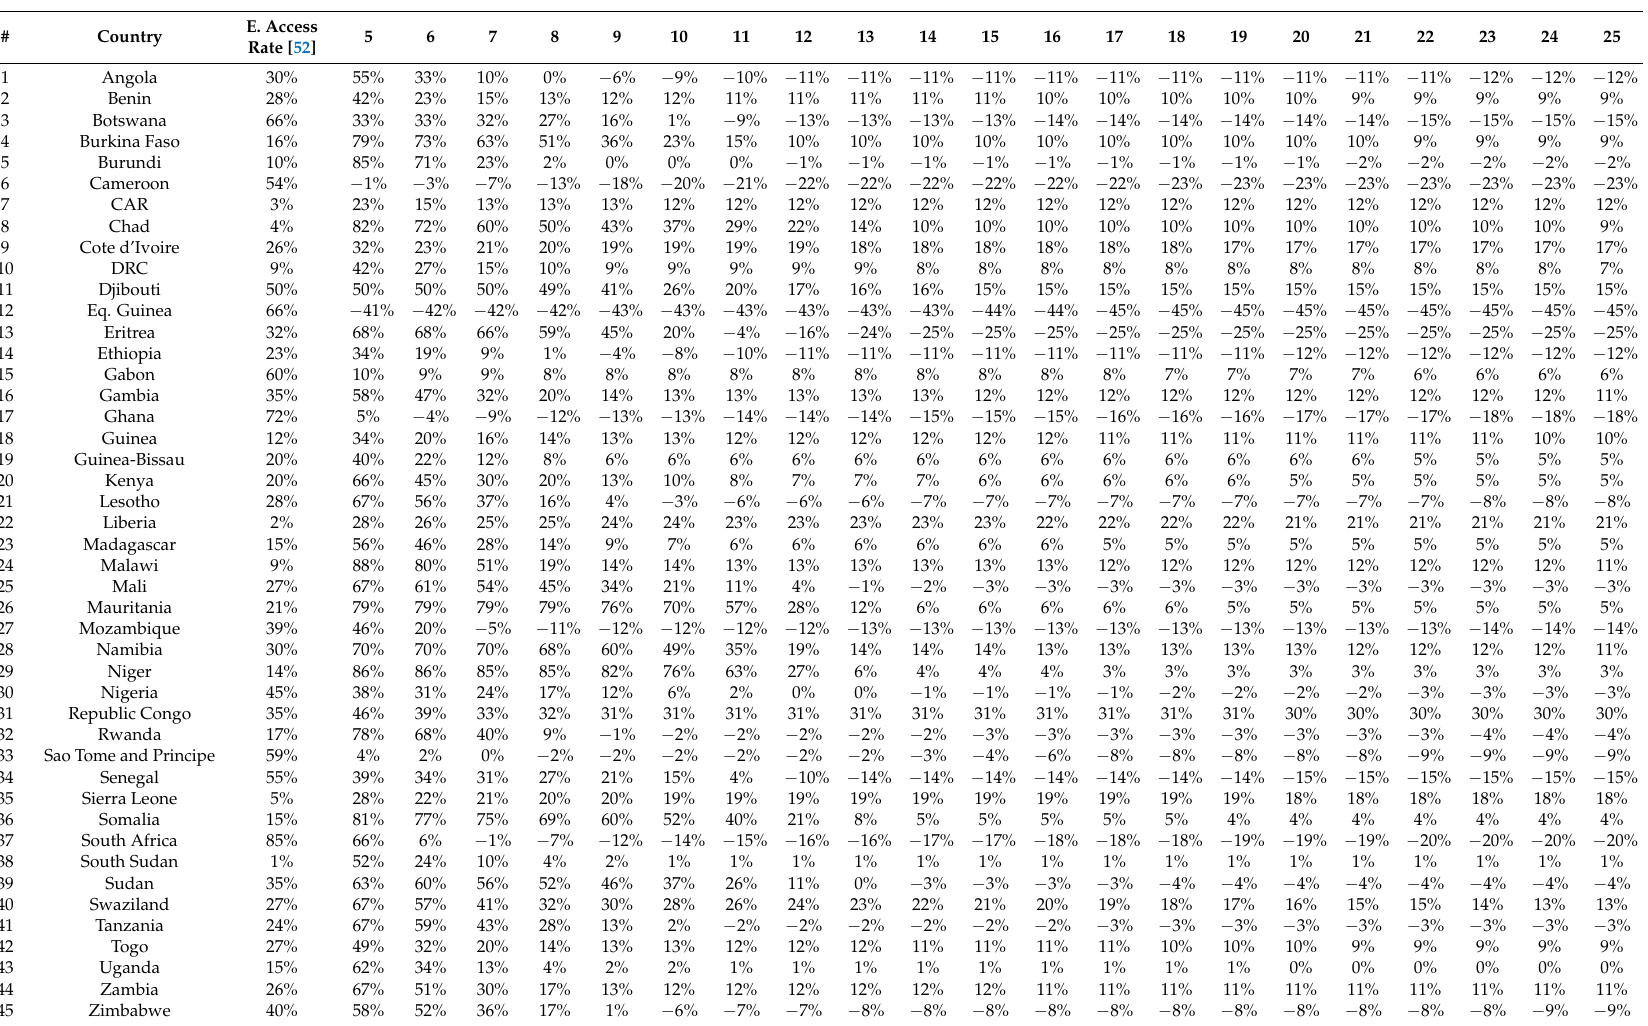
Table A2. Difference of calculated electrification rate (Night light band) to statistical electrification rate (IEA) in